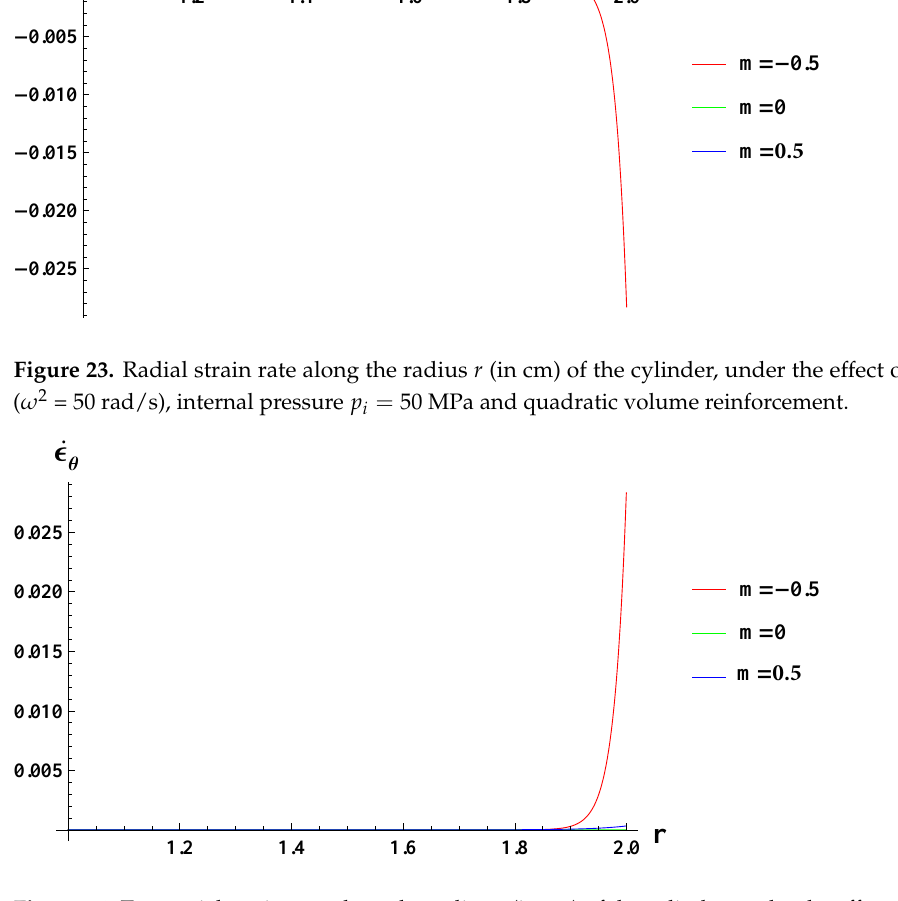
Figure 24. Tangential strain rate along the radius r (in cm) of the cylinder, under the effect of rotation ( ω 2 = 50 rad/s), internal pressure p i = 50 MPa and quadratic volume